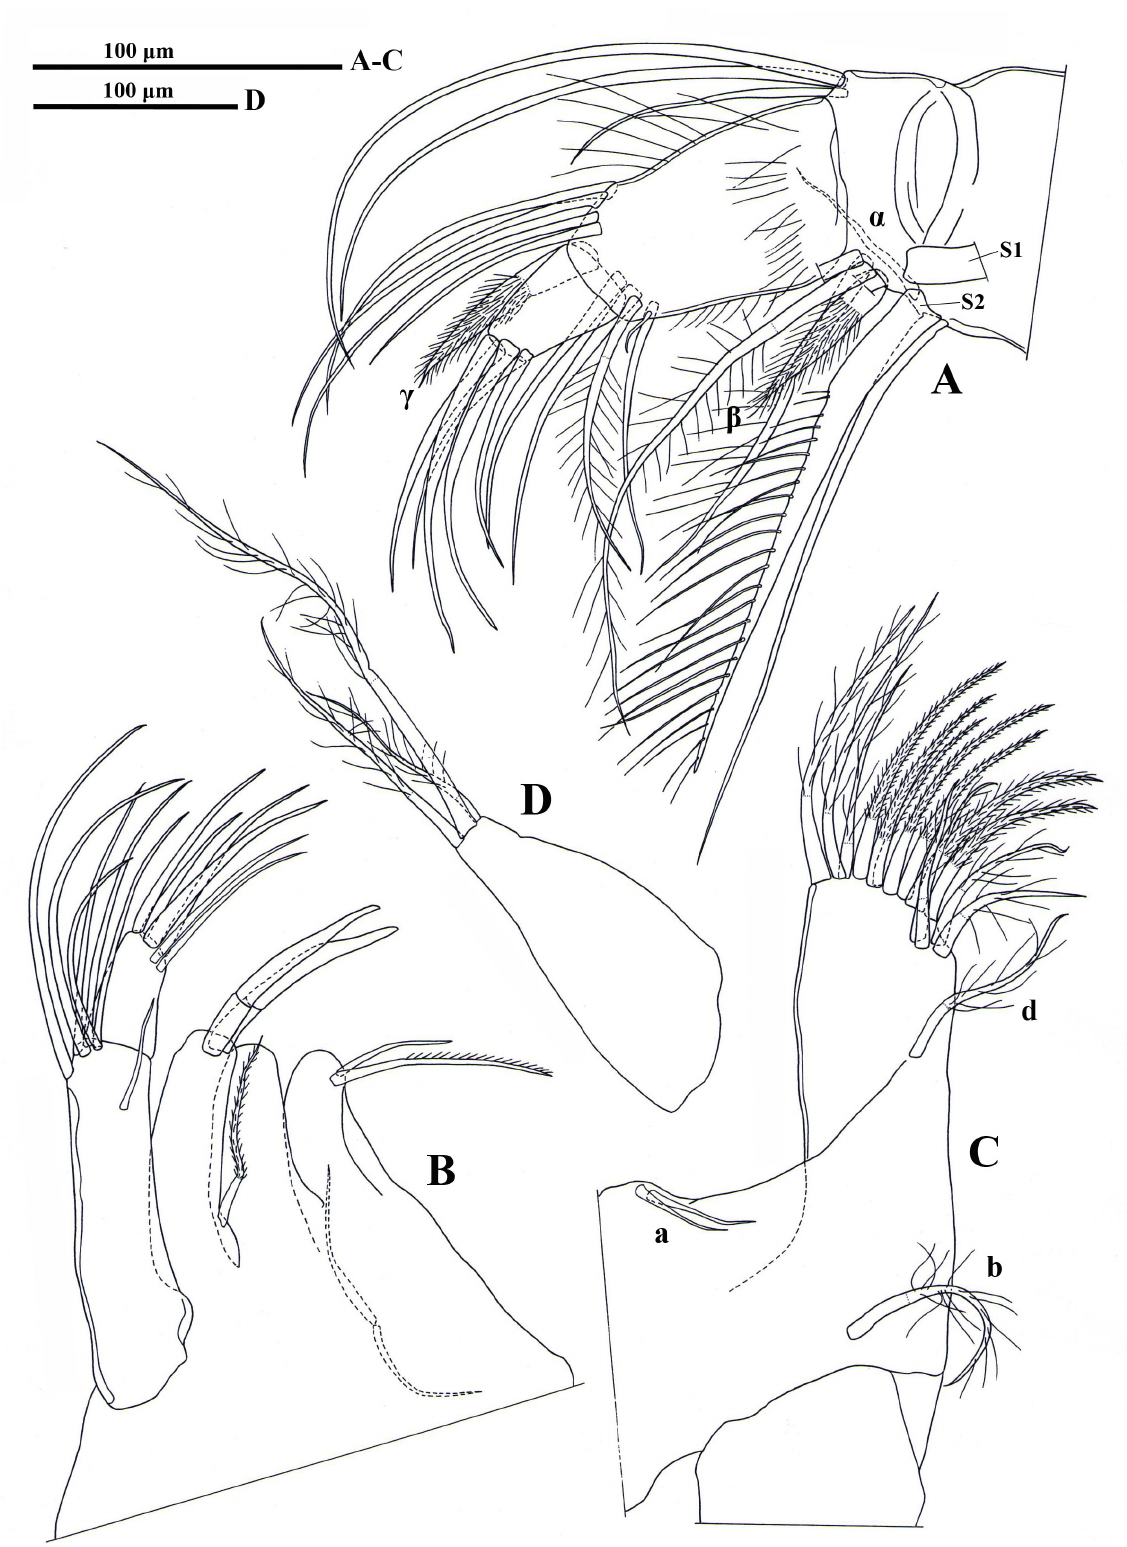
Fig. 9. Strandesia prachuapensis sp. nov. Holotype, ♀ (MSU-ZOC.303). A . Md-palp. B . Mx1. C . Basal protopod with medial endite of T1. D .